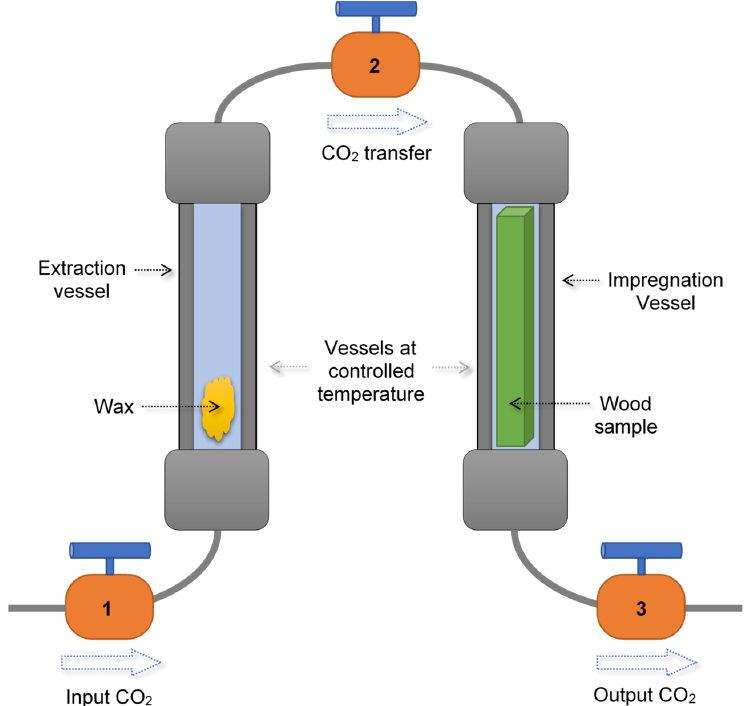
Forests 2022 , 13 , x FOR PEER REVIEW Figure 4. Schematic diagram of the scCO 2 extraction/impregnation process tested in this study.